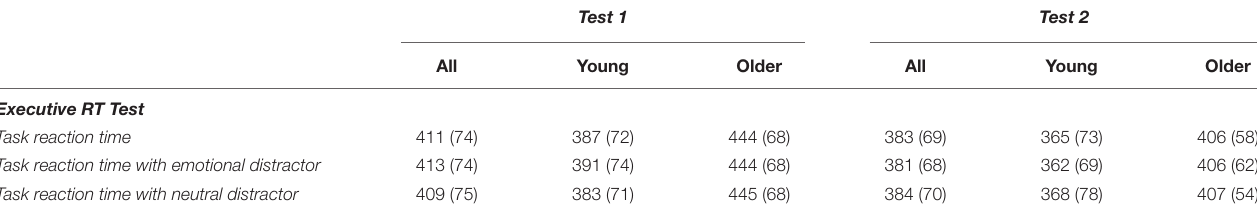
TABLE 2 | Reaction times with standard deviations.